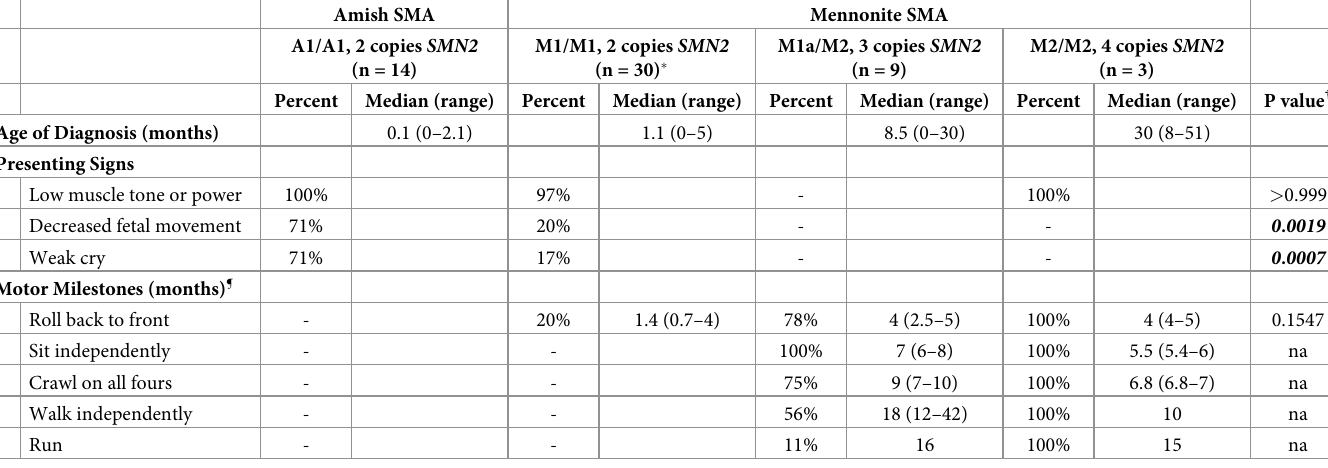
Table 1. Presenting signs and gross motor development of Amish (n = 14) and Mennonite (n = 42) children with spinal muscular atrophy (SMA) according to